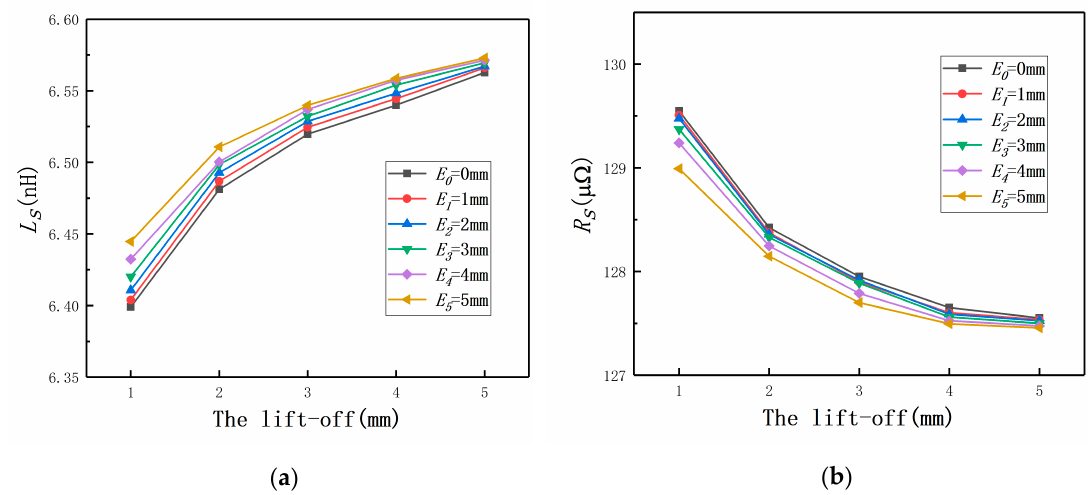
Figure 8. The change laws of the coil equivalent impedance under different eccentricities: ( a ) the coil equivalent inductance; ( b ) the coil equivalent resistance.